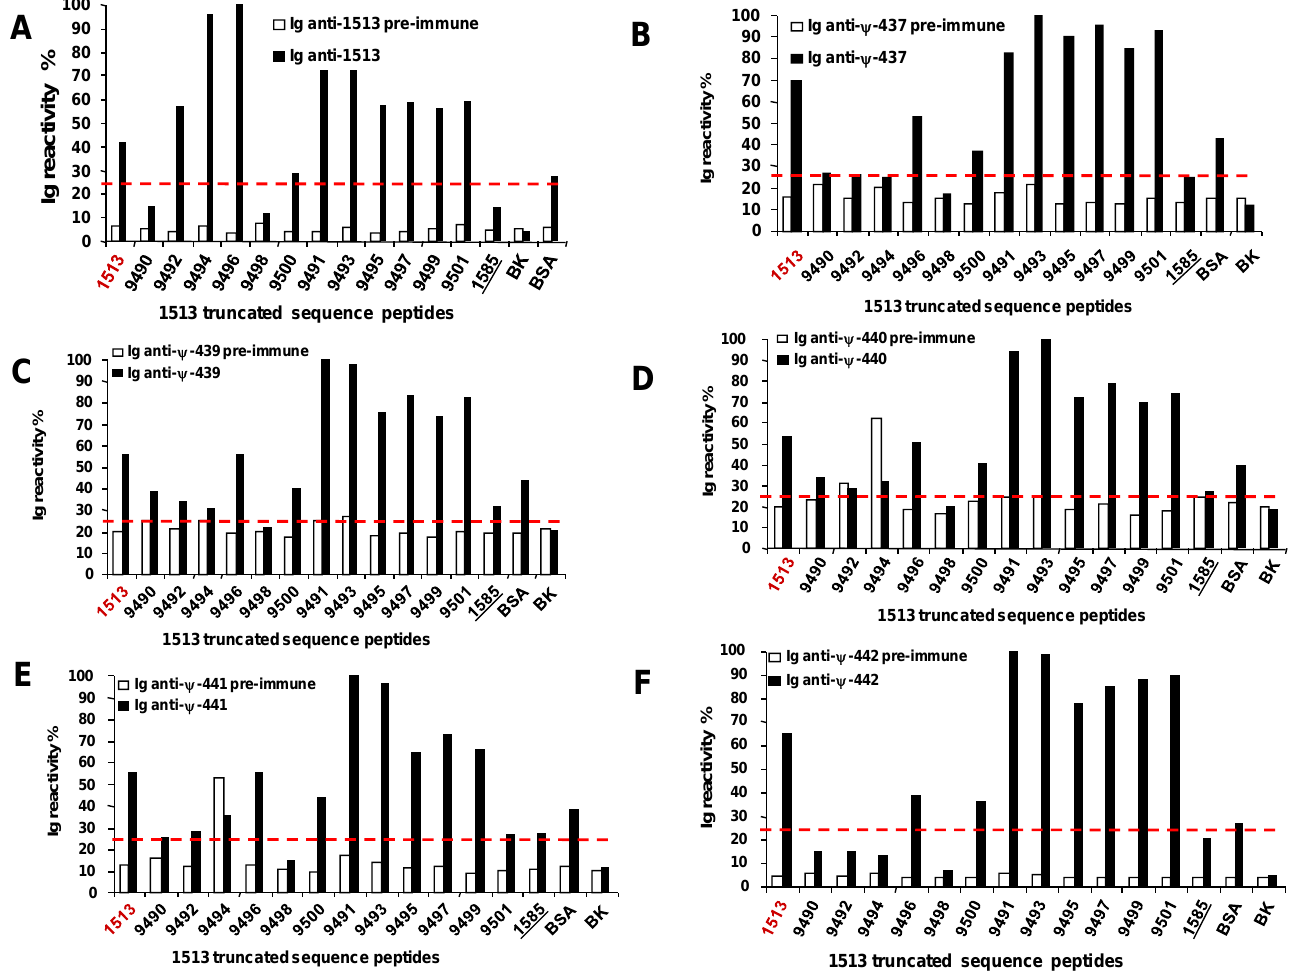
Figure 9. Mapping of 1513-pseudopeptide induced antibodies by competition ELISA. Ig reactivity % in all cases was normalized by selecting the highest optical density at 450 nm as the 100% reactivity. The threshold was arbitrarily established as 25% (dotted red lines). A. Reactivity of polyclonal antibodies induced by the entire native peptide 1513 sequence (in red) (MSP-1 42-61 ). B. Reactivity of polyclonal antibodies induced by the pseudopeptide  -437 (Val-Leu). C. Reactivity of polyclonal antibodies induced by the pseudopeptide  - 439 (Met-Val). D. Reactivity of polyclonal antibodies induced by the pseudopeptide  -440 (Lys-Met). E. Reactivity of polyclonal antibodies induced by the pseudopeptide  -441 (Glu-Lys). F. Reactivity of polyclonal antibodies induced by the pseudopeptide  -442 (Lys-Glu). In all cases peptide 1585 was employed as a non-relevant sequence, BSA as control and PBS as